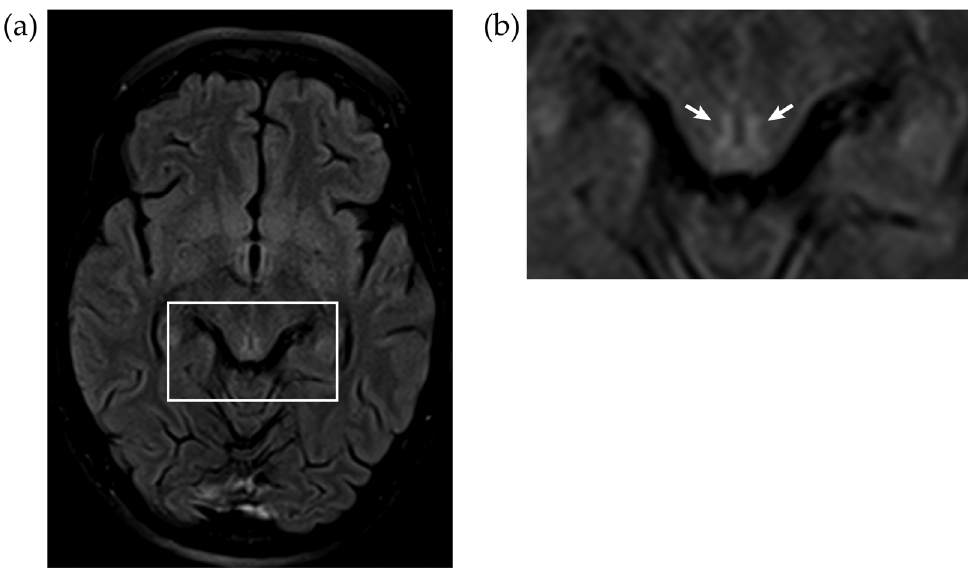
Figure 1. Axial 1.5 Tesla T2 fl uid-a tt enuated inversion recovery (FLAIR) weighted MRI scans show- ing the bilateral thalamic hyperintensities (arrows) during the stage with acute Wernicke encepha- lopathy signs, four days after hospital admission (echo time [TE] = 78 ms; repetition time [TR] = 5070 ms) ( a ), which were signi fi cantly reduced at the time of the neuropsychological assessment fi ve months later (TE = 84 ms; TR= 9000 ms) ( b ).